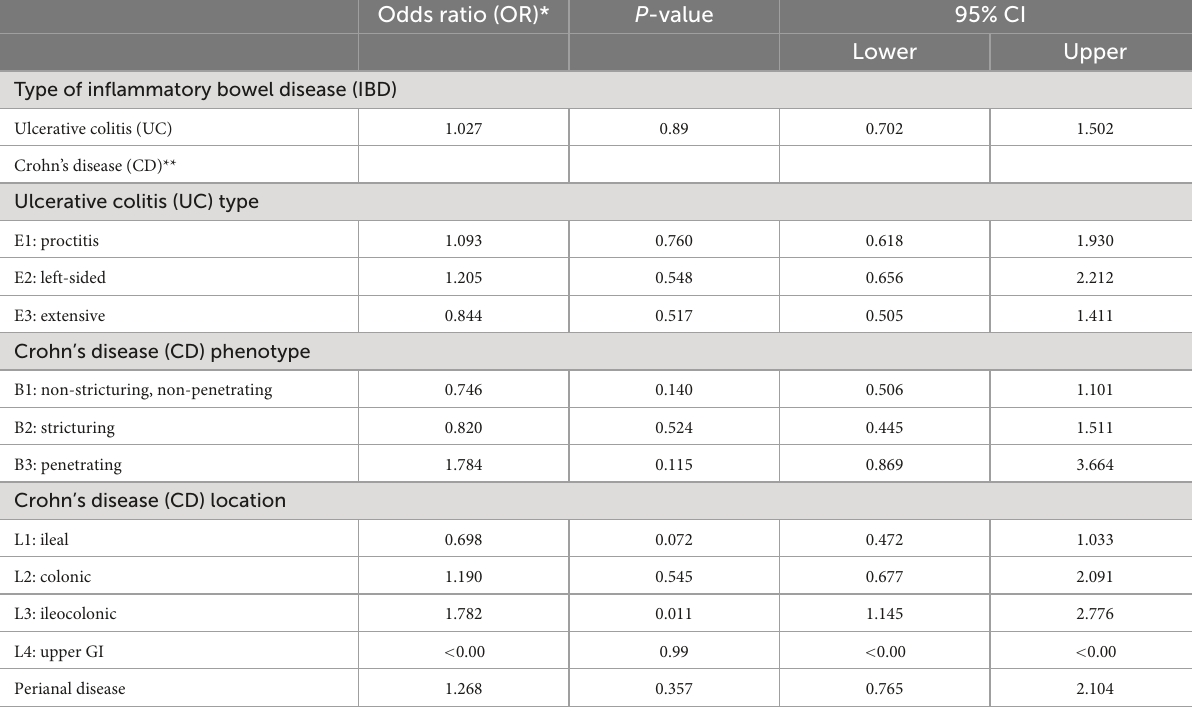
TABLE 4 Association between the type of inflammatory bowel disease (IBD) and being overweight or obese compared to having underweight or normal weight (total sample = 528). Odds ratio (OR)* P -value 95% CI Lower Upper Type of inflammatory bowel disease (IBD) Ulcerative colitis